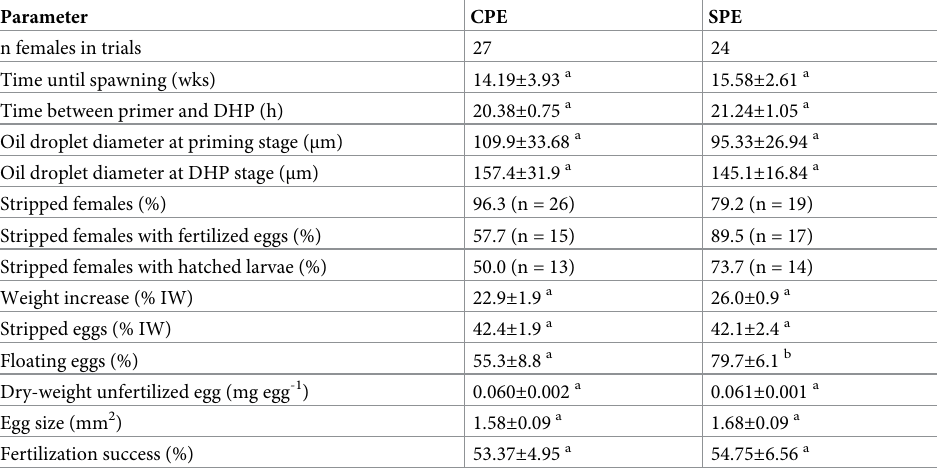
Table 2. Data on females and reproductive success of European eel, Anguilla anguilla in two successive trials. Dif- ferent lower-case letters represent a significant statistical difference (p <